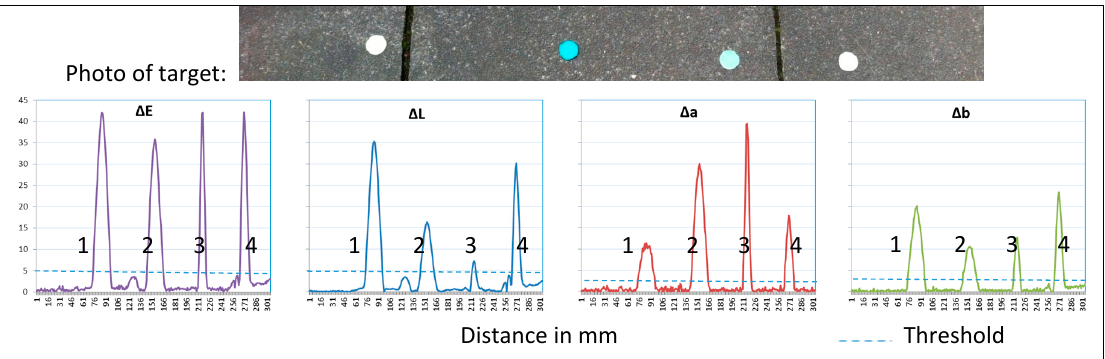
Figure 6. Reflection of paved ground with different colored cards, ∆ E, ∆ L, ∆ a, ∆ b and the defined threshold for detection.